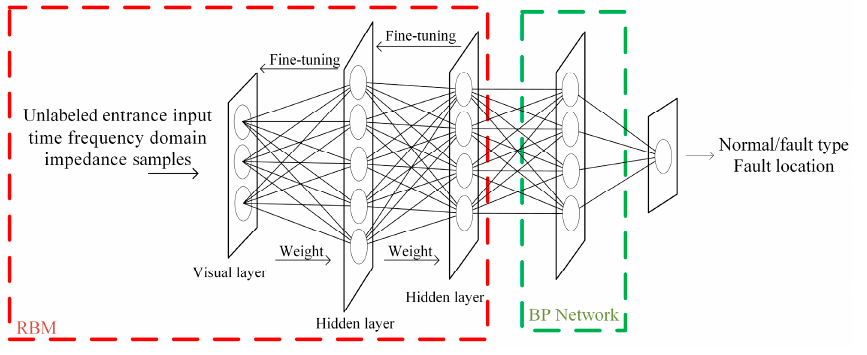
Figure 2. Basic structure of the DBN model.